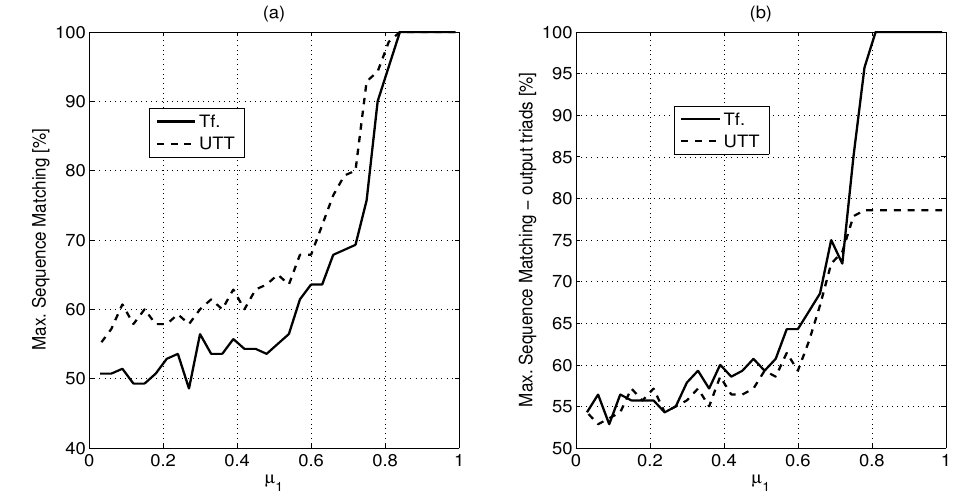
Figure 11. Hello Goodbye—maximal sequence matching of transformations ( a ) and triads ( b